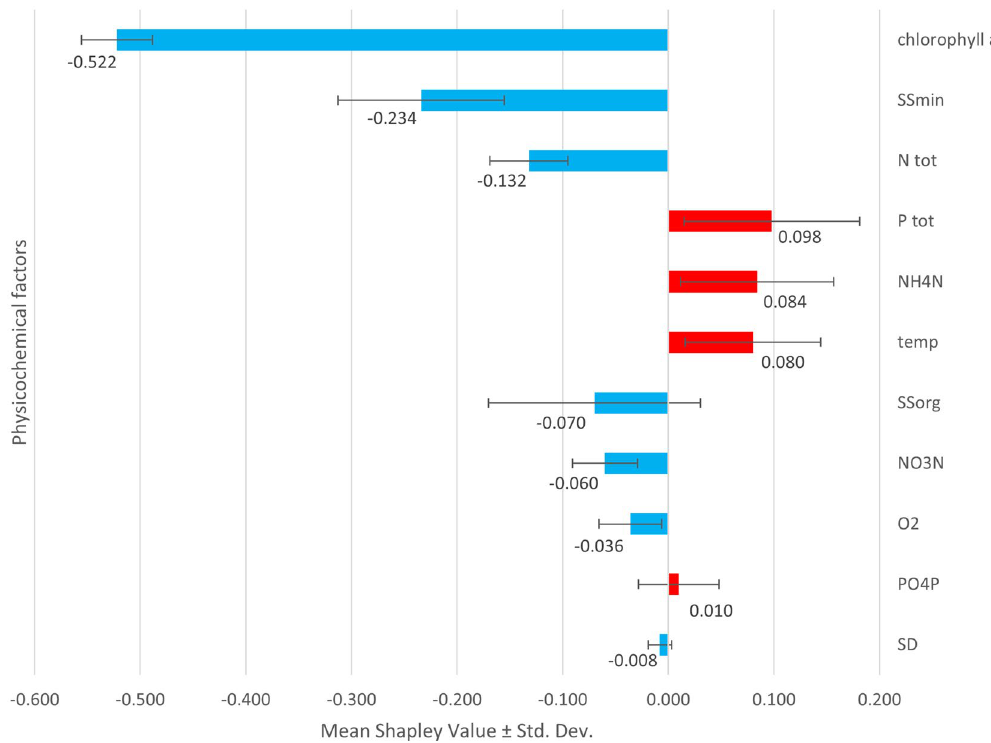
Figure 4. The importance of physico-chemical factors during the study period as an effect of water warming during winter in the classification XGBoost-SHAP modelling. Mean and standard deviation of Shapley value of 5 running models (Fig. S2). The abbreviations are explained in the subsection Methods, Sampling and laboratory works and in the Supplementary Information, Table